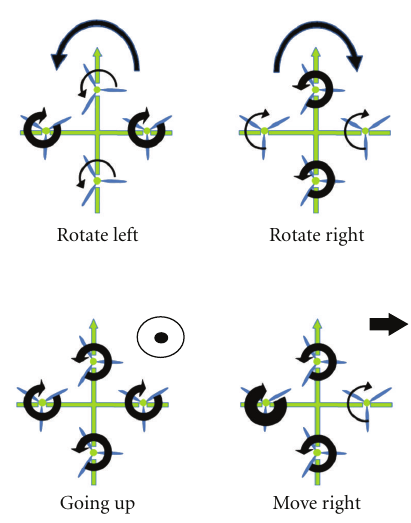
Figure 11: Quad-rotor concept motion description, the arrow width is proportional to propeller rotational speed adapted from